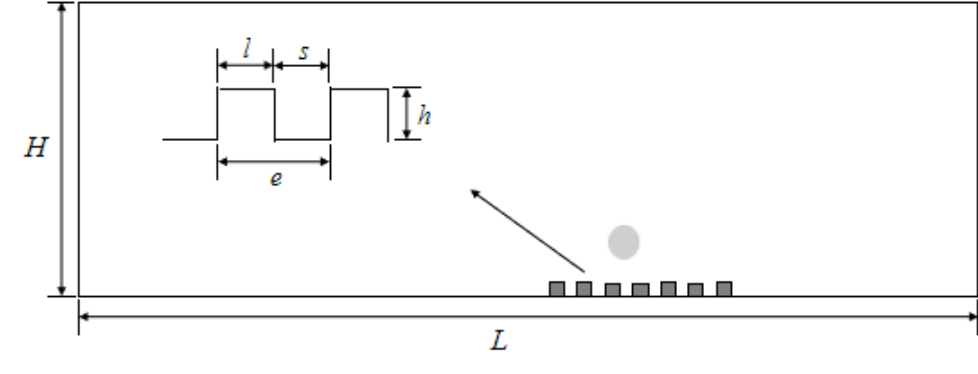
Figure 3. Schematic diagram of the microstructure model.